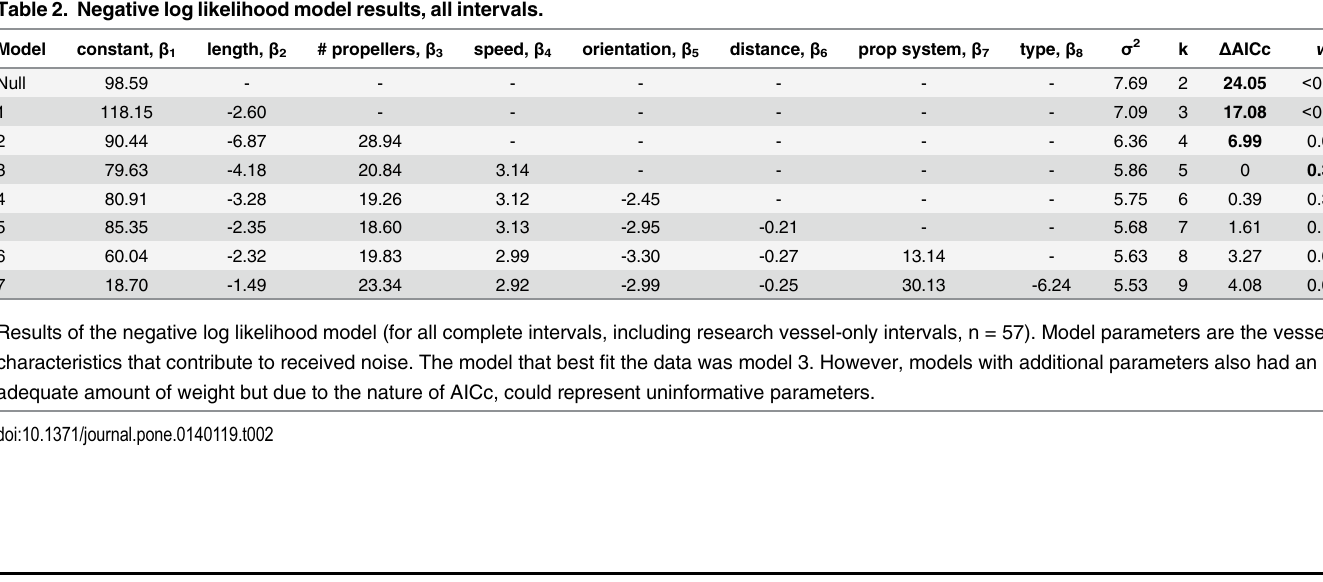
Table 2. Negative log likelihood model results, all intervals. Model